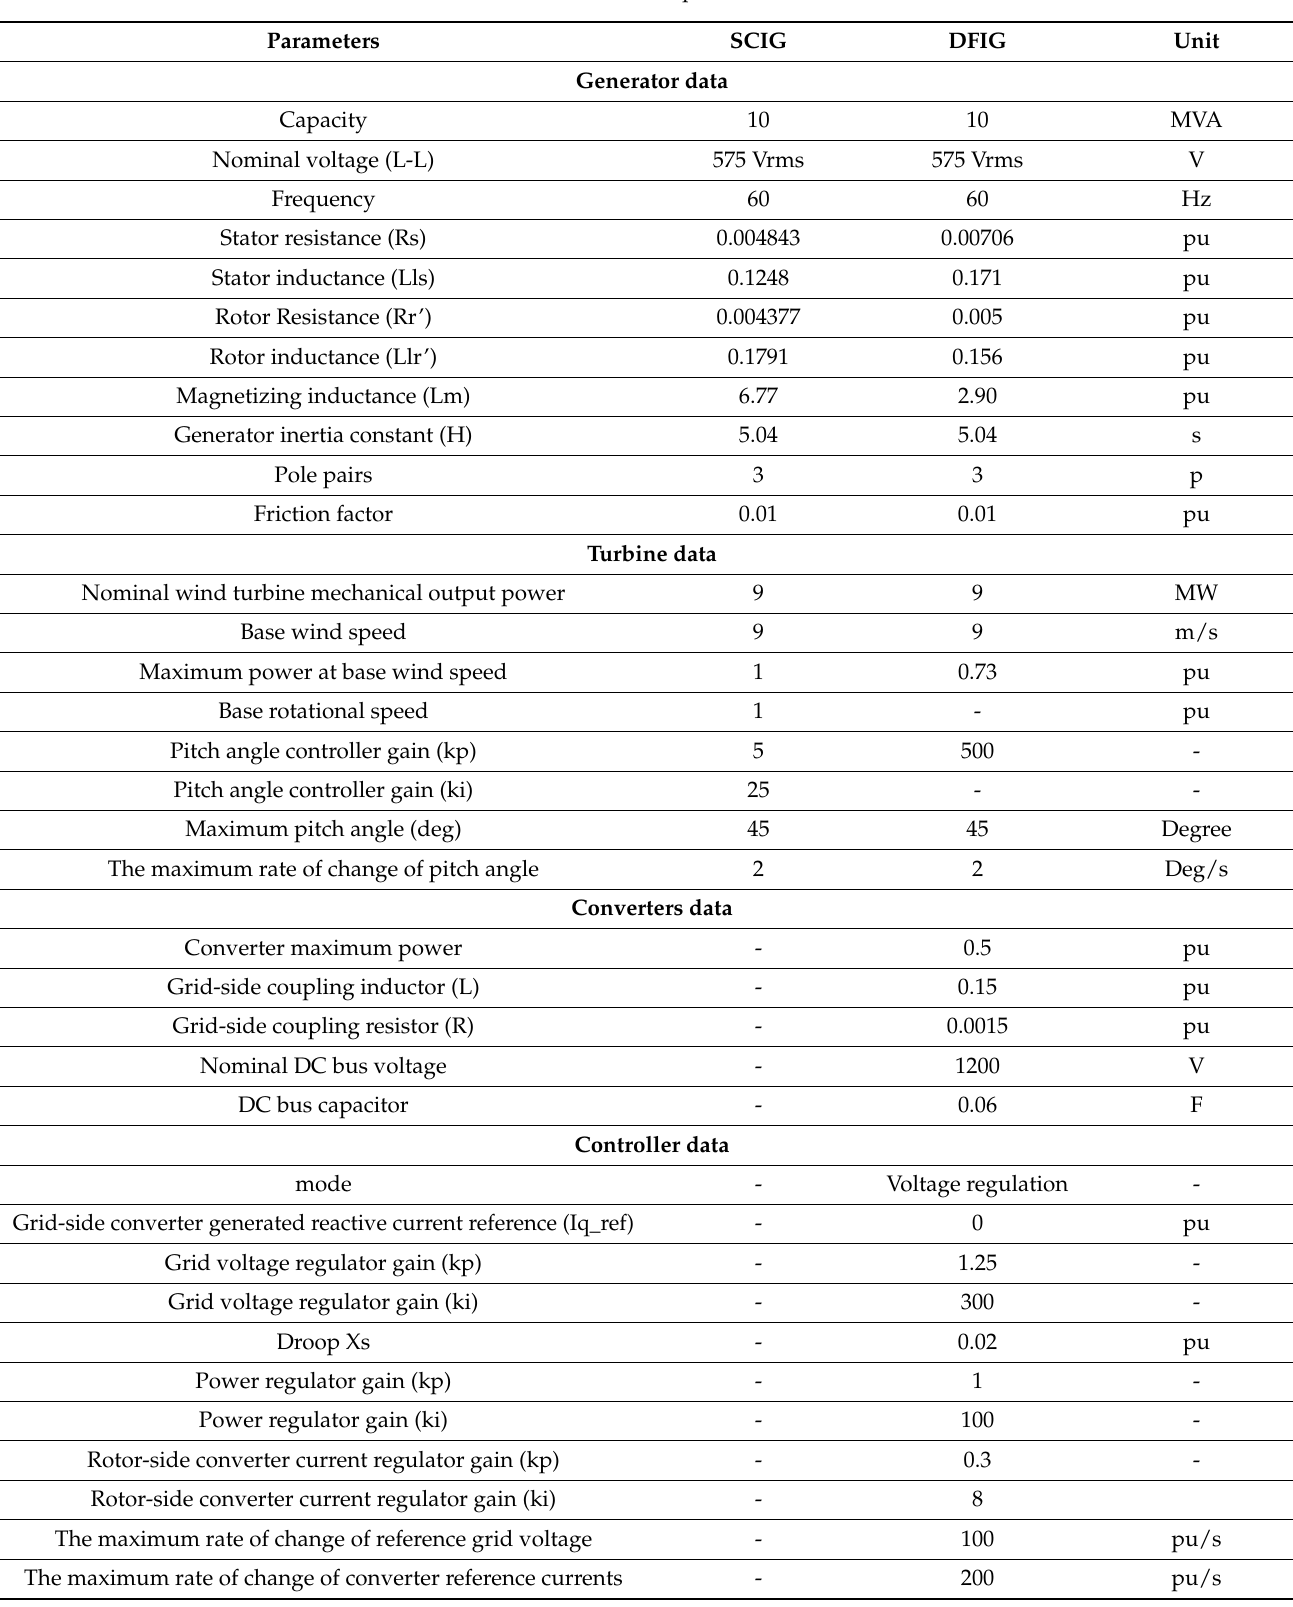
Table 2. Generator, turbine, converters, and controller parameter values for simulated SCIG and